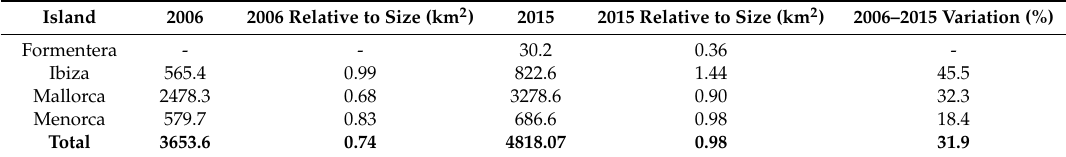
Table 1. Evaporative water loss from swimming pools in the Balearic Islands (million L). Island 2006 2006 Relative to Size (km 2